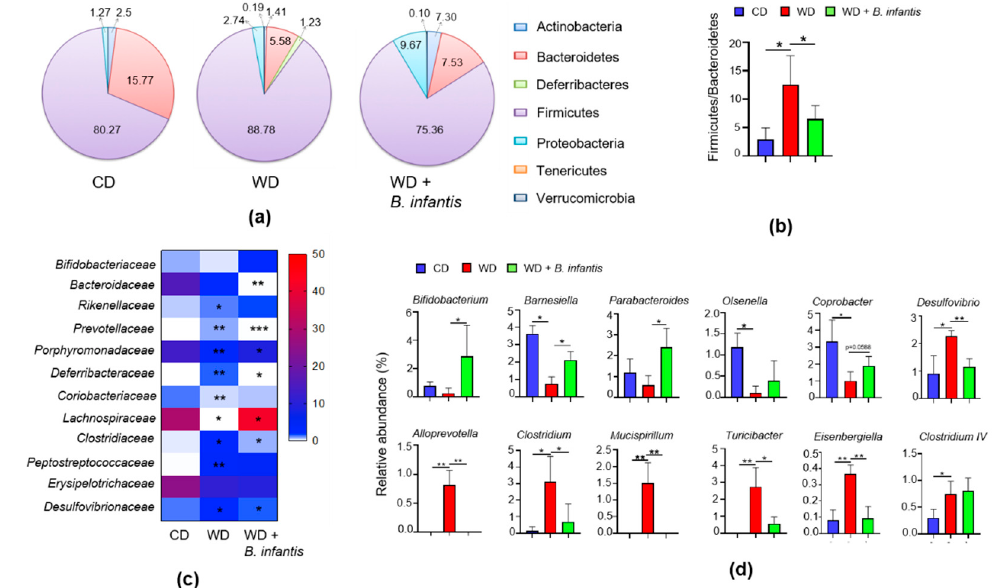
Figure 4. Probiotic B. infantis prevented gut dysbiosis induced by WD: ( a ) Relative abundance of cecal microbiota at the phylum level; ( b ) The ratio between phylum Firmicutes and Bacteroidetes; ( c ) Relative abundance of cecal microbiota at the family level; ( d ) Relative abundance of cecal microbiota at genus level in control diet (CD) and WD fed mice treated with and without B. infantis for 2 months (CD, n = 6; WD, n = 6; WD + B. infantis, n = 4). Data are expressed as mean ± SD. * p < 0.05, ** p < 0.01, *** p < 0.001, CD-fed mice compared with WD-fed mice and WD-fed mice compared with B. infantis treated mice.